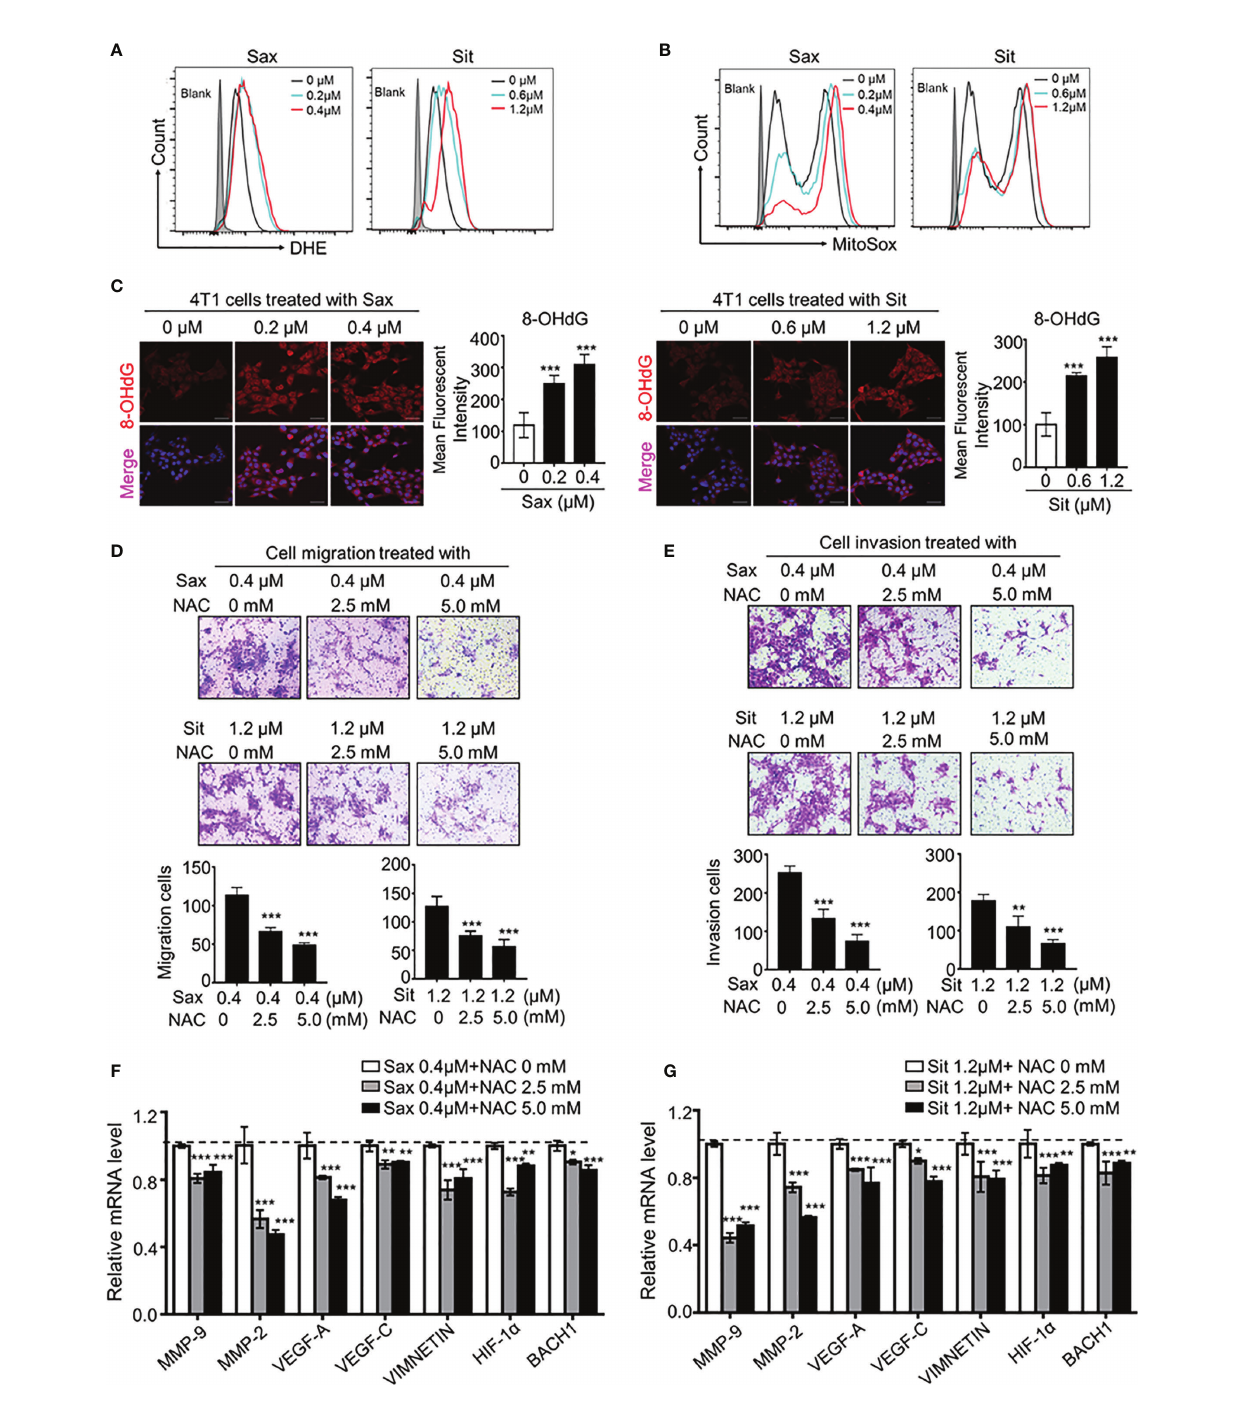
FIGURE 2 | ROS scavenger reverses DPP-4i-driven metastasis. (A, B) DPP4i triggers ROS overproduction. 4T1 cells were treated with DPP-4i. Intracellular ROS and mROS were detected in DPP-4i-treated BC cells by FCM using DHE staining (A) and MitoSox staining (B) . (C) DPP-4i induces DNA damage in BC cells. 4T1 cells were treated with DPP-4i and DNA damage marker 8-oxo-deoxyguanosine (8-OHdG) was detected by IF staining. (D, E) ROS scavenger abrogates DPP-4i -driven cell migration and invasion in vitro . 4T1 cells were subject to cell migration (D) and cell invasion (E) assays upon co-treatment of DPP-4i and NAC for 24 h. Migration or invasion cells were counted in 5 to 10 random fi elds. (F, G) ROS scavenger abrogates DPP-4i-driven metastasis-associated gene levels. 4T1 cells were co-treated with or without DPP-4i and NAC for 4 h and metastasis-associated gene levels were detected by qRT-PCR. b -actin gene was as an internal control. Data are presented as mean ± SD of three independent experiments. Representative images are shown. Scale bars: 50 m m. *p<0.05, **p<0.01, and ***p<0.001 between the indicated groups determined by one-way analysis of variance